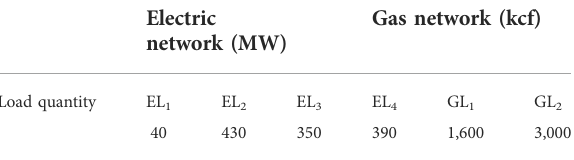
FIGURE 3 Topology of the fi ve-bus power system and the seven-node gas system.